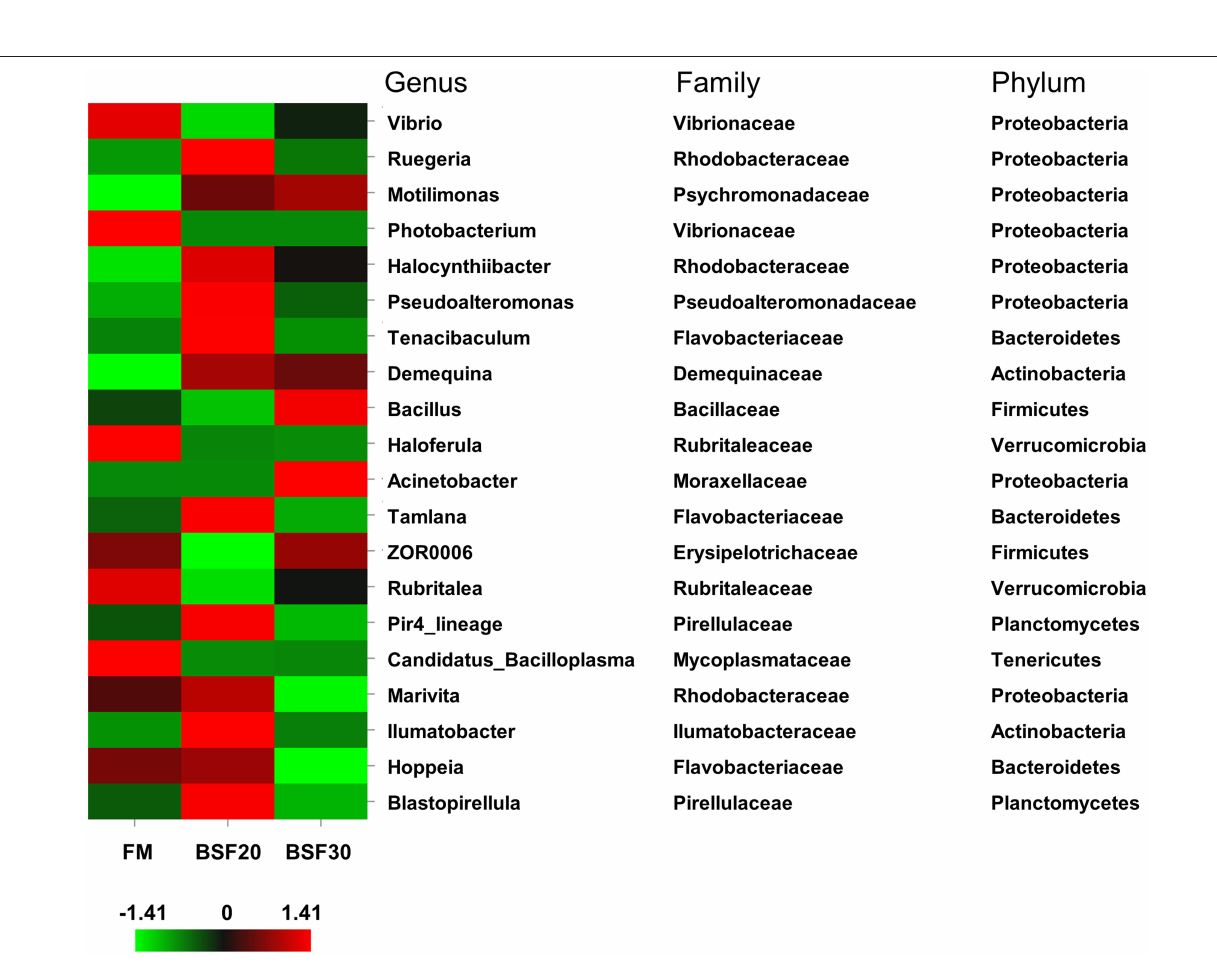
Frontiers in Marine Science |